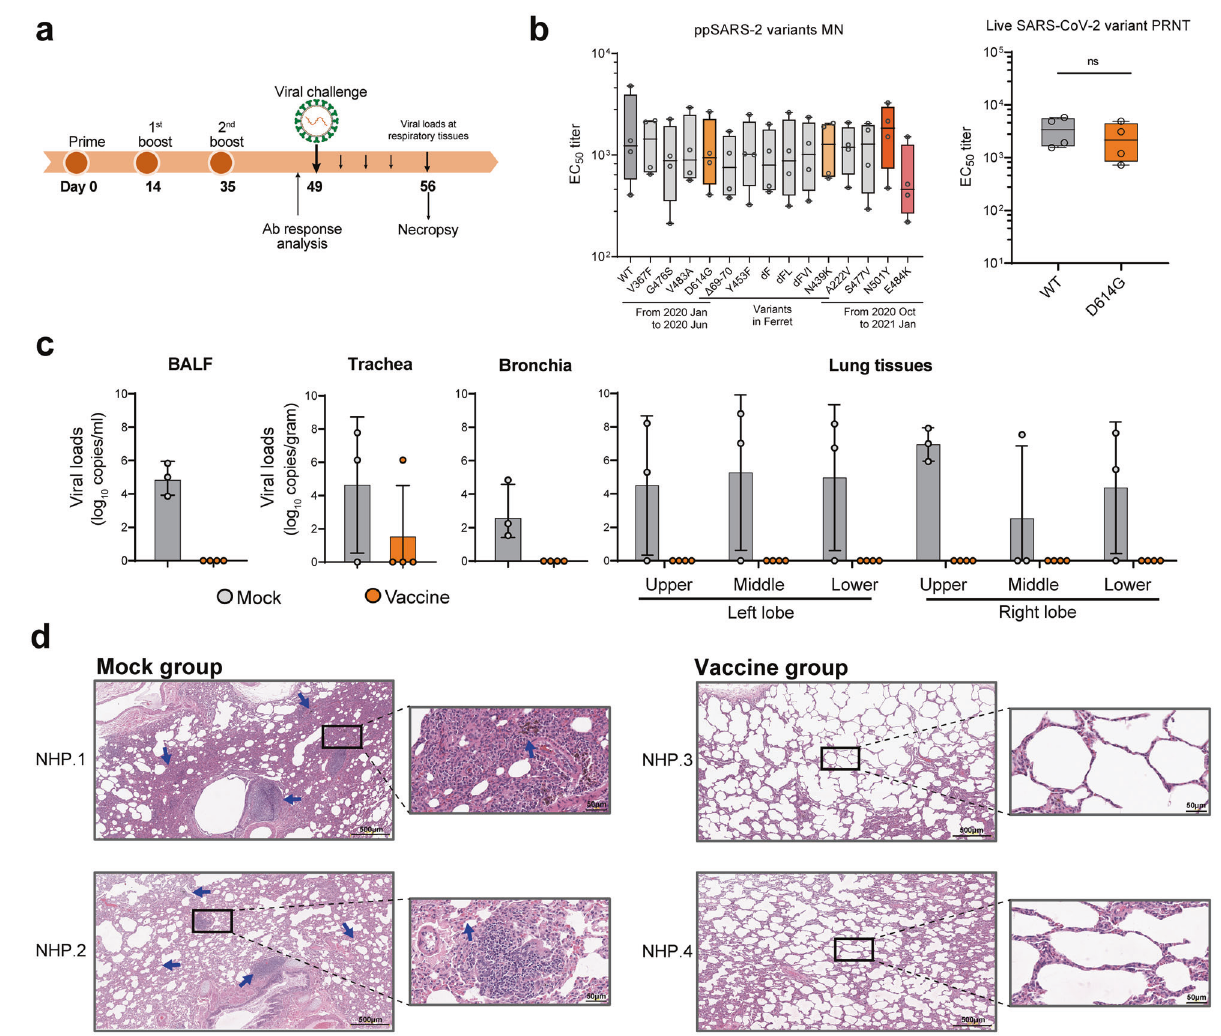
Fig. 6 Induction of suf fi cient protection against SARS-CoV-2 in rhesus macaques by SW0123. a Schematic study design. Rhesus macaques received three doses of SW0123, and were intranasally and intratracheally challenged with 1 × 10 6 PFU of SARS-CoV-2 two weeks after the 2nd boost. Animals in mock group received PBS injection. Samples were collected at the indicated time points. b Titers of NAbs for neutralizing ability against pseudotype SARS-CoV-2 with indicated mutation points in S protein or were tested against live D614G mutant and wide-type strain (Wuhan/IVDC-HB-01/2019) using plaque reduction neutralization test. c Animals were euthanized and necropsied at 7 dpi. gRNA copies in trachea, bronchia, BAL fl uid and lung tissues were determined. d H&E staining of lung tissue sections from animals. Blue arrows point to lung pathological lesions. Images from two representative animals in each group are shown. Two-tailed Mann – Whitney test was used for statistical analysis. * p ≤ 0.05; ** p < 0.01; *** p < 0.001; **** p <